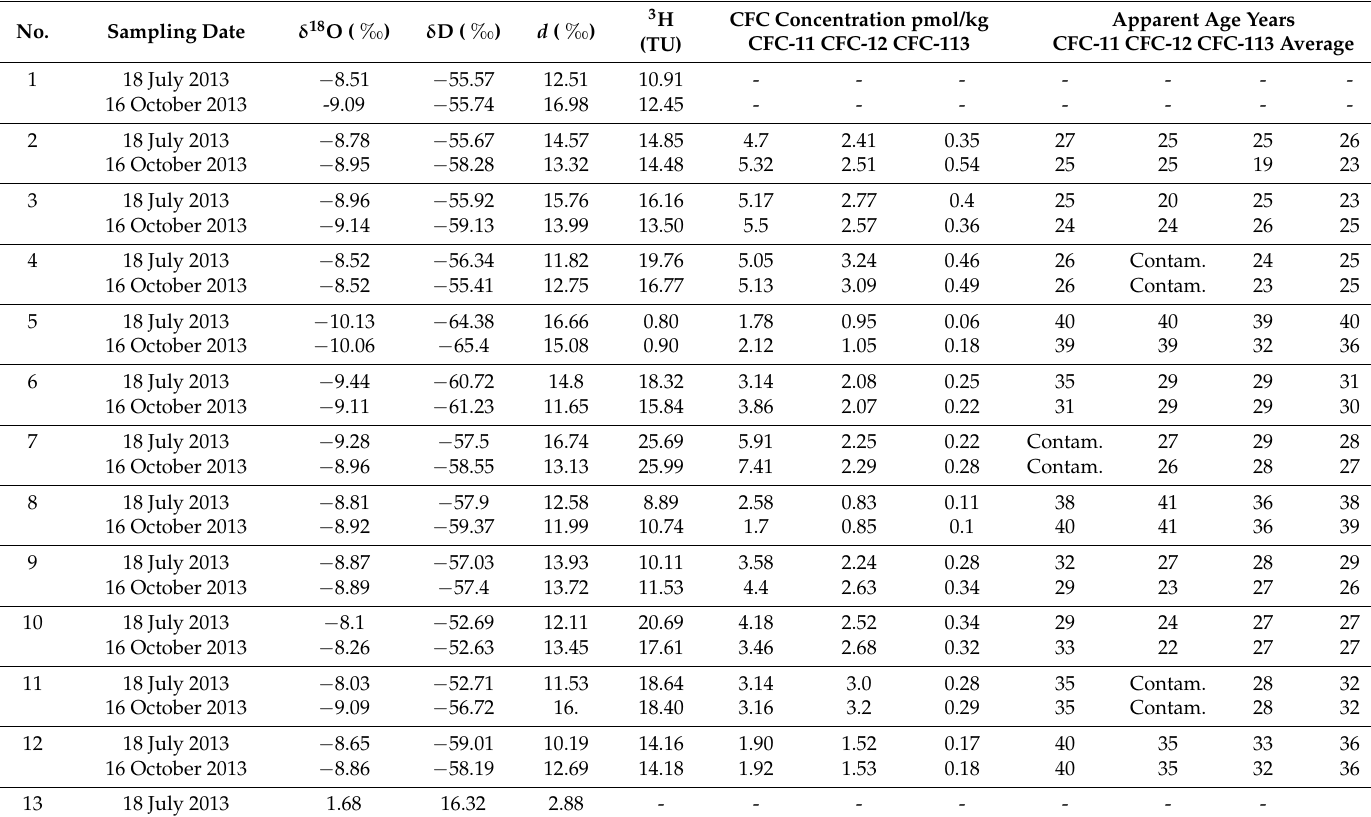
Table 3. Summary of isotopic and geochemical tracer data collected for samples in the study